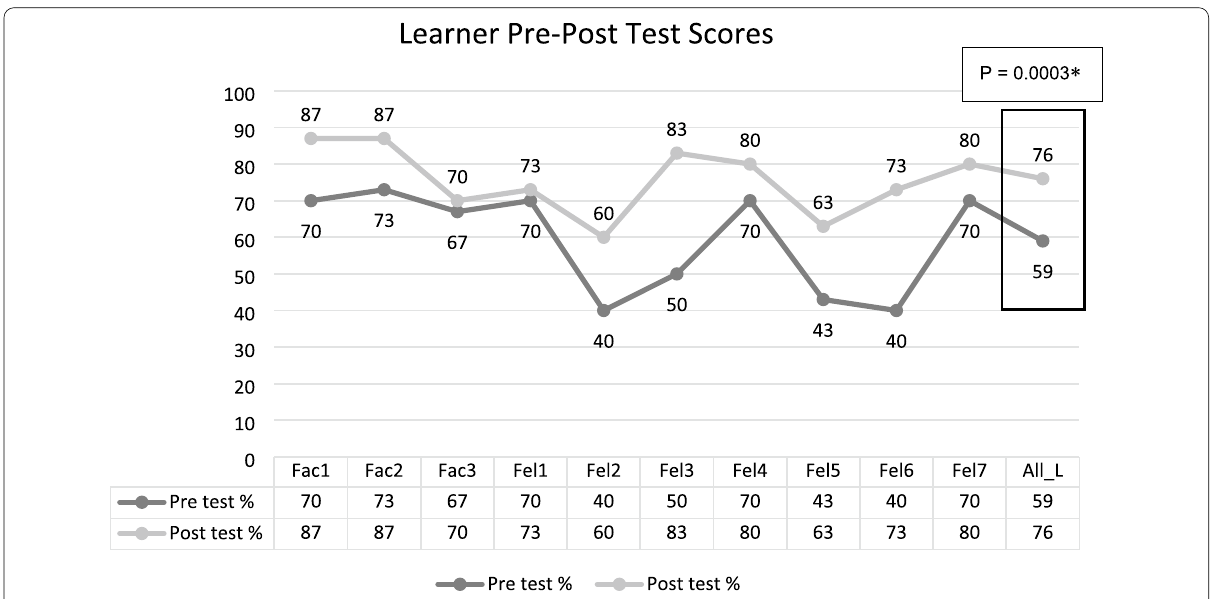
Fig. 1 Learner pre- and post-course test scores for individual learners, including faculty and fellows. The mean of post-test scores for all learners improved significantly after the curriculum (p 0.0003). Fac faculty, Fel fellow , All_L all =